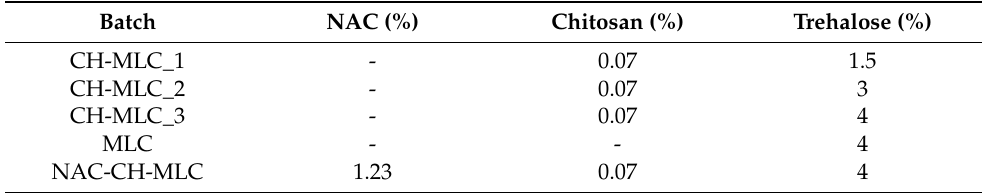
Table 4. Percentage composition ( p / p ) of the microstructured lipid carrier (MLC) suspension (for all batches, the following substances were kept at the same concentration: POE-POP: 1.2%, glycerol dibehenate 3.2%, caprylic/capric triglycerides 1.2%, polygliceryl-4 sorbitan olivate phosphate 0.4%).